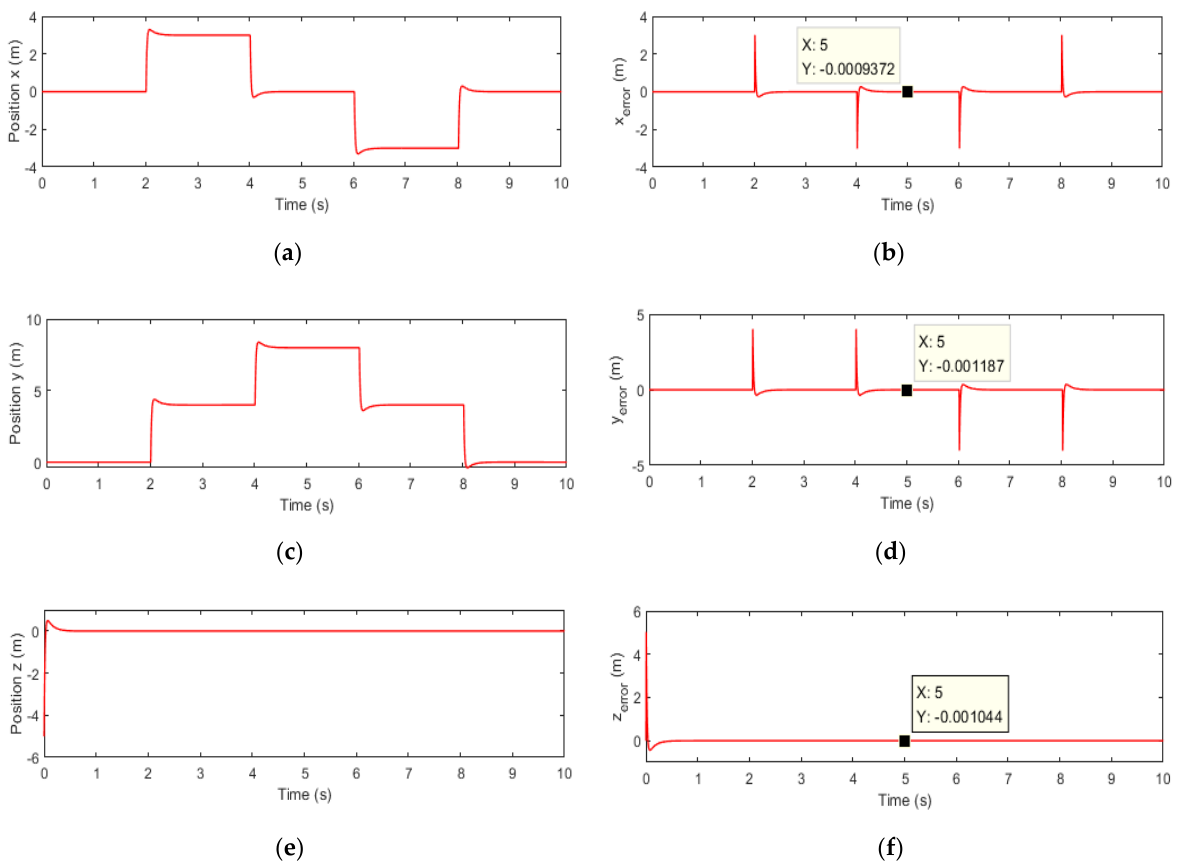
Figure 5. ( a , c , e ) Position response of quadrotor. ( b , d , f ) Position error between desired and real trajectories. Figure 6a,c,e show the Euler’s angle response for the trajectory tracking. The Euler’s angle error between the desired and real trajectories under disturbance is shown in Figure 6b,d,f. As shown in these figures, when disturbance was considered, the developed IB-SMC enabled the attitude-tracking capability of the quadrotor.